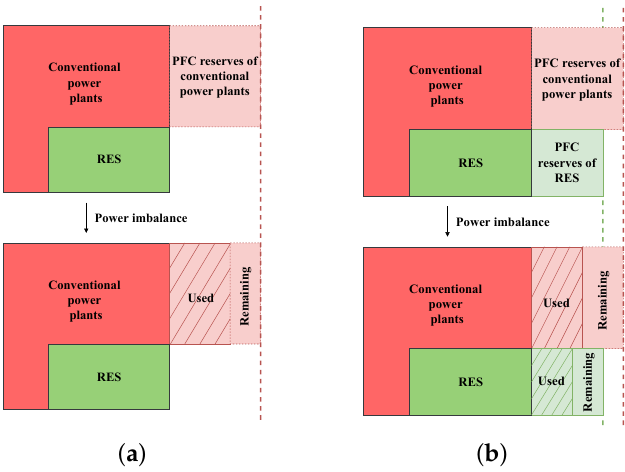
Figure 1. Change in primary frequency control (PFC) reserves from current to future power systems: ( a ) Current situation; ( b ) Future situation.